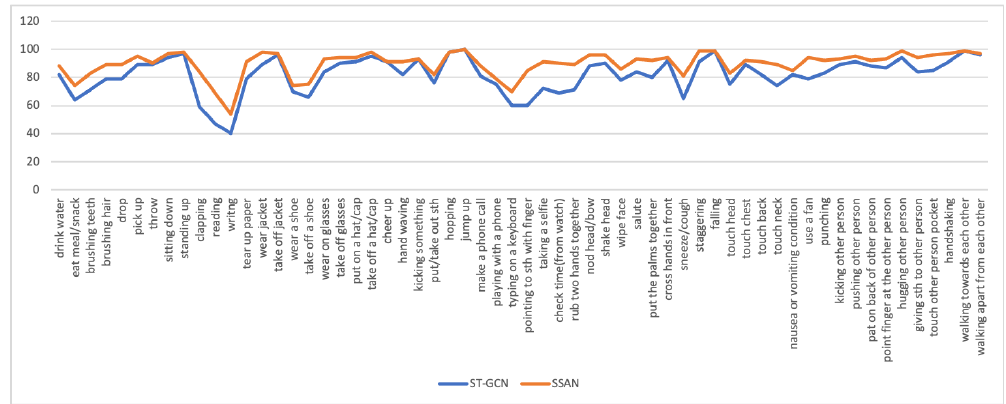
Figure 6. The influence of the number of consecutive frames n on the model based on the NTU RGB+D skeleton data set.